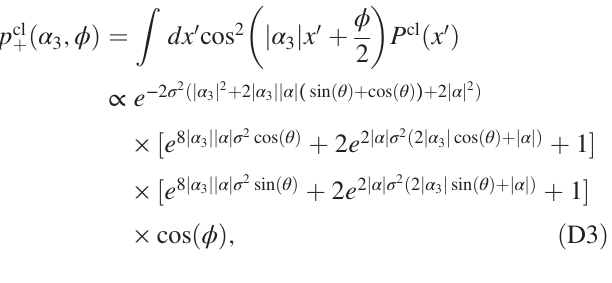
ffiffiffi p 2 g for σ ≥ j α j . A plot of this function (Fig. 7) looks qualitatively the same as Fig. 6(b), with the difference being attributable to the superposition of